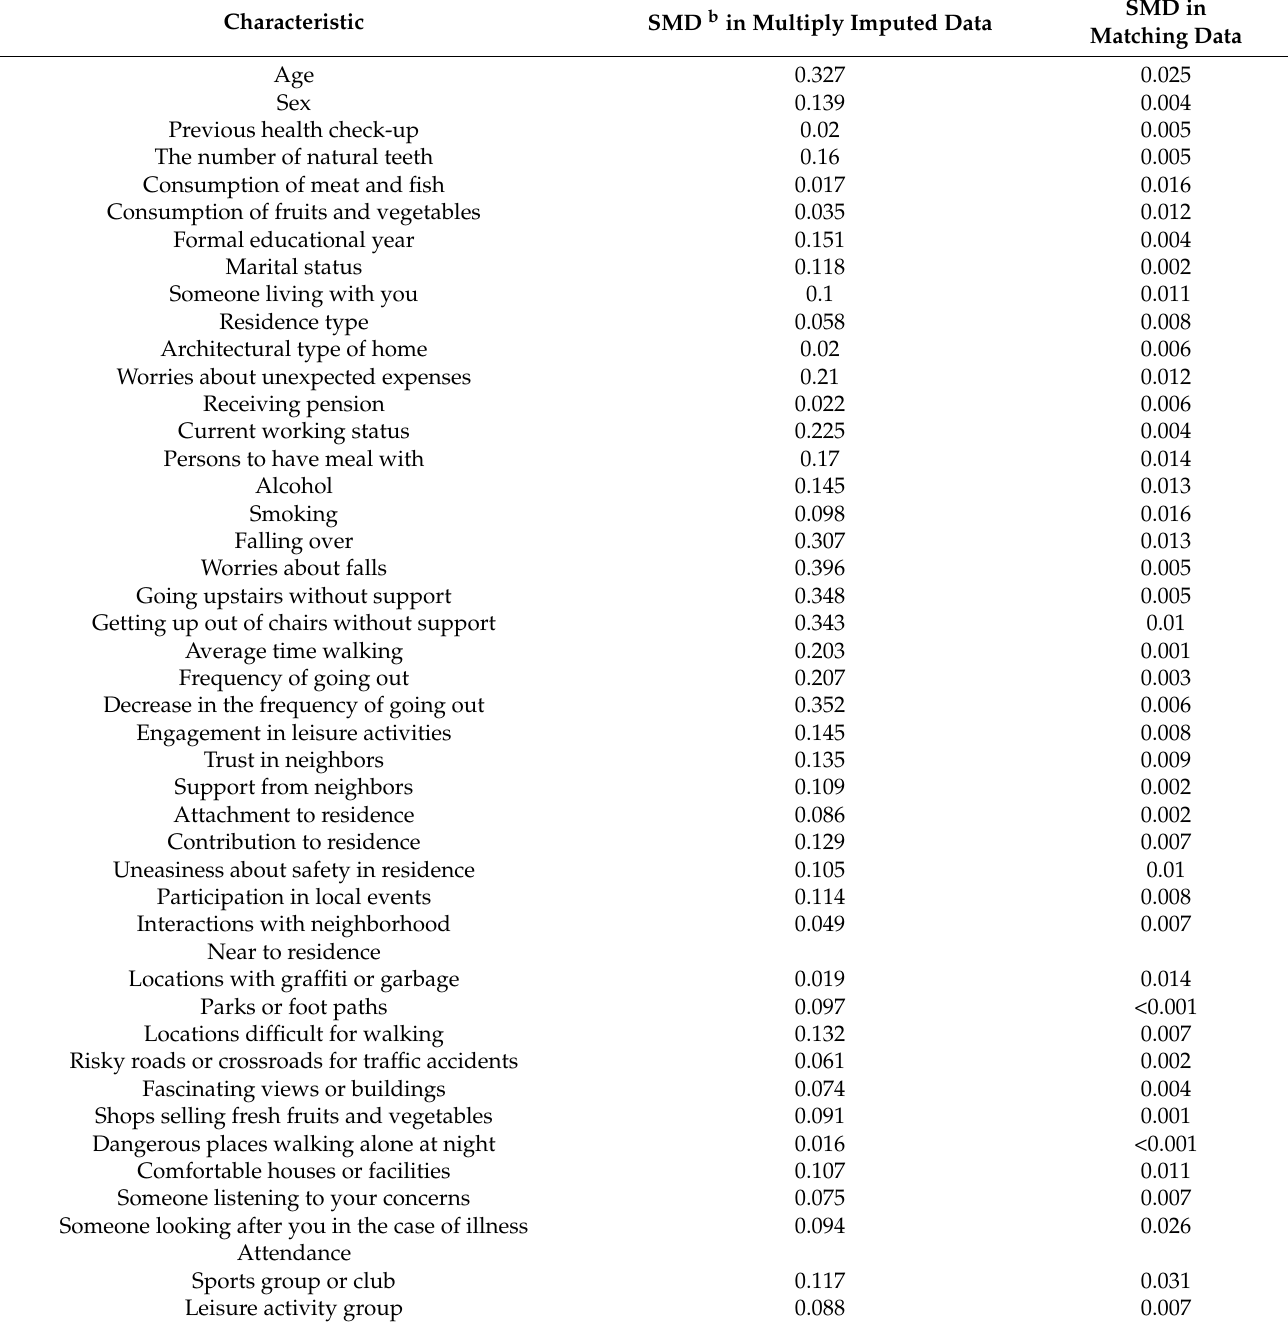
Table 3. Standardized mean differences with or without CMM a , before and after Propensity Score